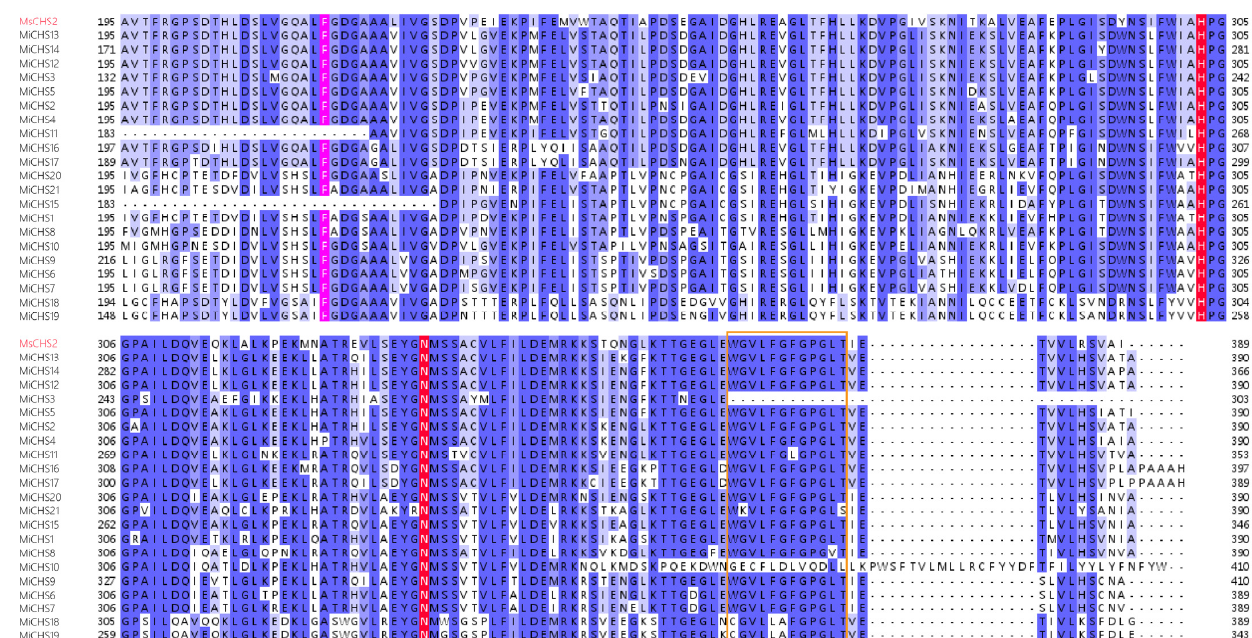
Figure 1. Multiple sequence alignment of the deduced peptides of MiCHS, together with MsCHS2 (P30074), from Medicago sativa . The CHS/STS signature motifs (WGVLFGFGPGLT) are framed by an orange box. The active site Cys-His-Asn triad and Phe based on MsCHS2 are highlighted in red and purple, respectively. The darker blue indicates higher numbers of identical residues. Gaps are represented by short hyphens.